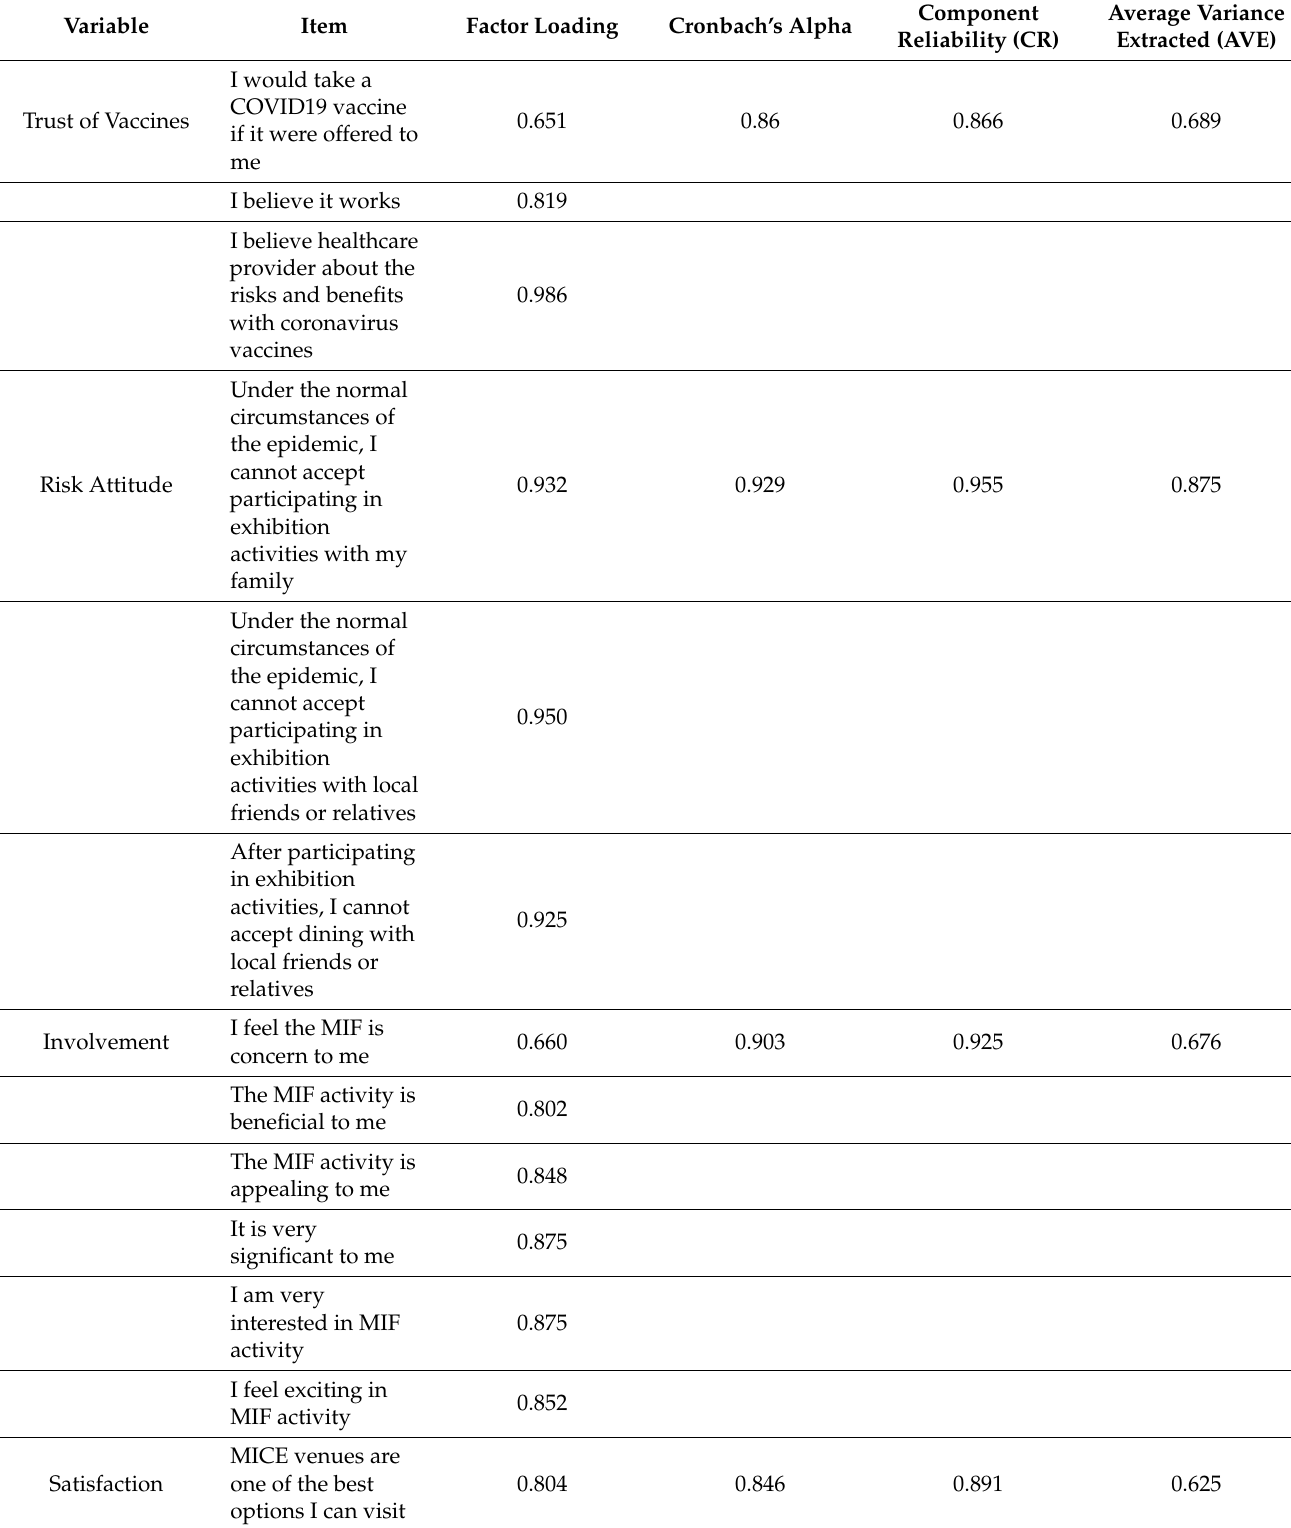
Table 2. Reliability, CR, and